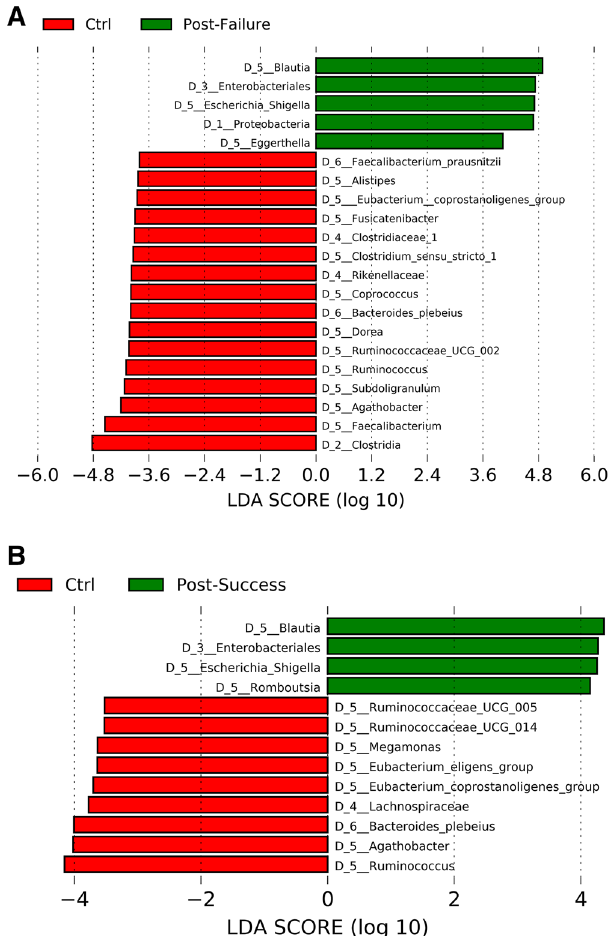
Figure 5. Differences in taxa abundance between ( A ) non-responders and ( B ) responders, compared to healthy individuals. The search for differential taxa was performed using LEfSe (Kruskal–Wallis test between classes, p-value < 0.05; threshold for discriminative taxa, logarithmic LDA score > 3.5).